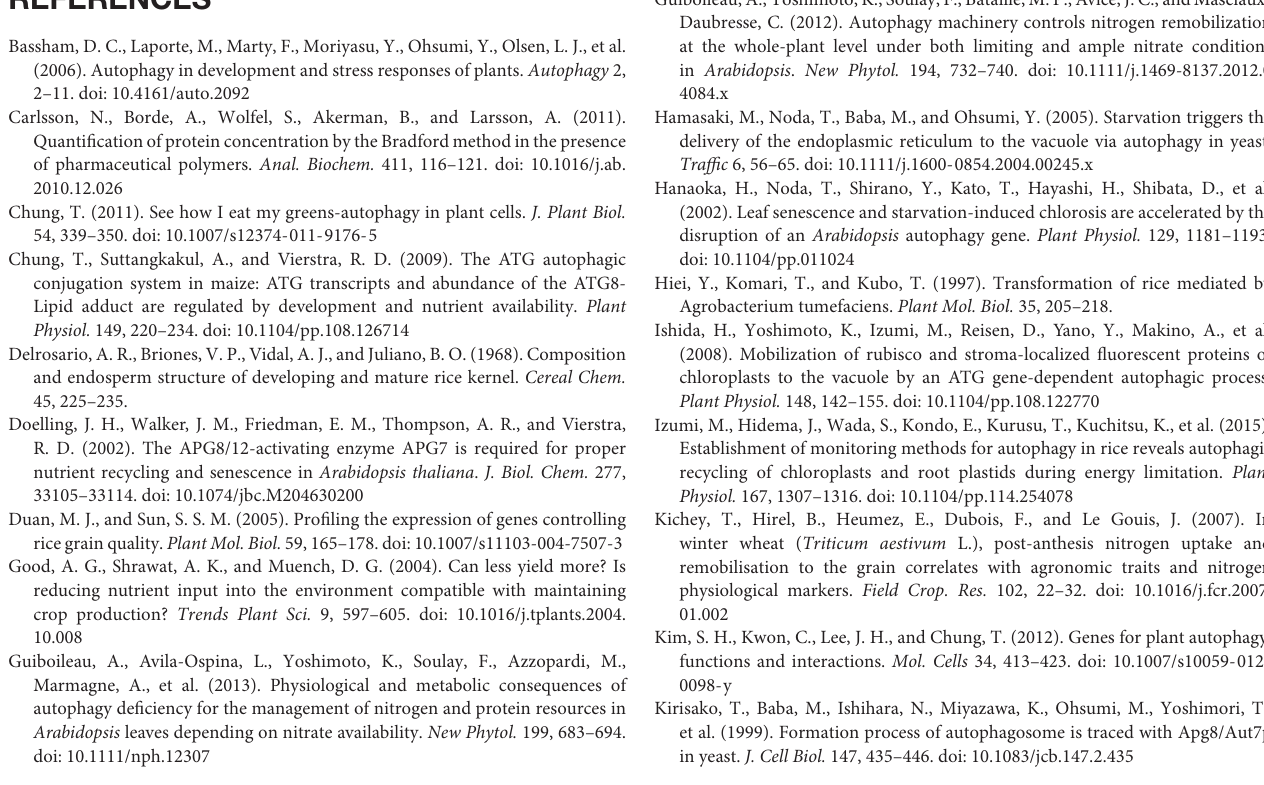
FIGURE S1 | Phylogenetic tree of ATG8s by amino sequence alignment of different species. Glycine max (Gm), Arabidopsis thaliana (At), Saccharomyces cerevisiae (Sc), Selaginella moellendorffii (Sm), Oryza sativa (Os), Homo sapiens (Hs), Solanum lycopersicum (Sly), Triticum aestivum (Ta), and Brachypodium distachyon (Bd). Deduced amino acid sequences were aligned by CLUSTALX; the phylogenetic tree was generated by the neighbor-joining method and constructed using MEGA4. FIGURE S2 | Alignment of ATG8 amino acid sequence and 3D model of OsATG8b. (A) Alignment of ATG8 amino acid sequences from rice, Arabidopsis , human, and yeast. Arrows indicate the C-terminal glycine residue, which is processed by ATG4 cysteine protease. Residues constituting W- and L-sites are colored red and green, respectively. Sc, S . cerevisiae ; Hs, Homo sapiens ; At, Arabidopsis thaliana ; Os, Oryza sativa . (B) 3D models of OsATG8b. Two hydrophobic pockets responsible for the recognition of Trp and Leu are labeled W-site and L-site, respectively, and circled. FIGURE S3 | Subcellular localization of sGFP-OsATG8b in rice protoplasts. Bars = 1 µ m. FIGURE S4 | Immunoblot detection of the vacuolar delivery of GFP in GFP-OsATG8b lines and immunoblot analysis with OsATG8b antibodies. Total proteins extracted from shoots of 14-day-old-seedlings in GFP-OsATG8b (OE) and GFP (G1) transgenic lines and ZH11. (A) Total proteins were subjected to immunoblot analysis with GFP antibody. (B) OsATG8b antibodies recognize the endogenous proteins OsATG8(a/b/c) as well as the GFP fusion proteins in ZH11 and GFP-OsATG8b transgenic lines. FIGURE S5 | The expression of OsATG8a and OsATG8c in ZH11, OsATG8b -OE, and OsATG8b -RNAi lines. (A) Sequence comparison with other homologous genes for construction of OsATG8b RNAi. The RNAi fragment is demarcated by the box. (B,C) qRT-PCR analysis of OsATG8a and OsATG8c expression. The seedlings of ZH11, OsATG8b- OE, and OsATG8b -RNAi at four-leaf stage were